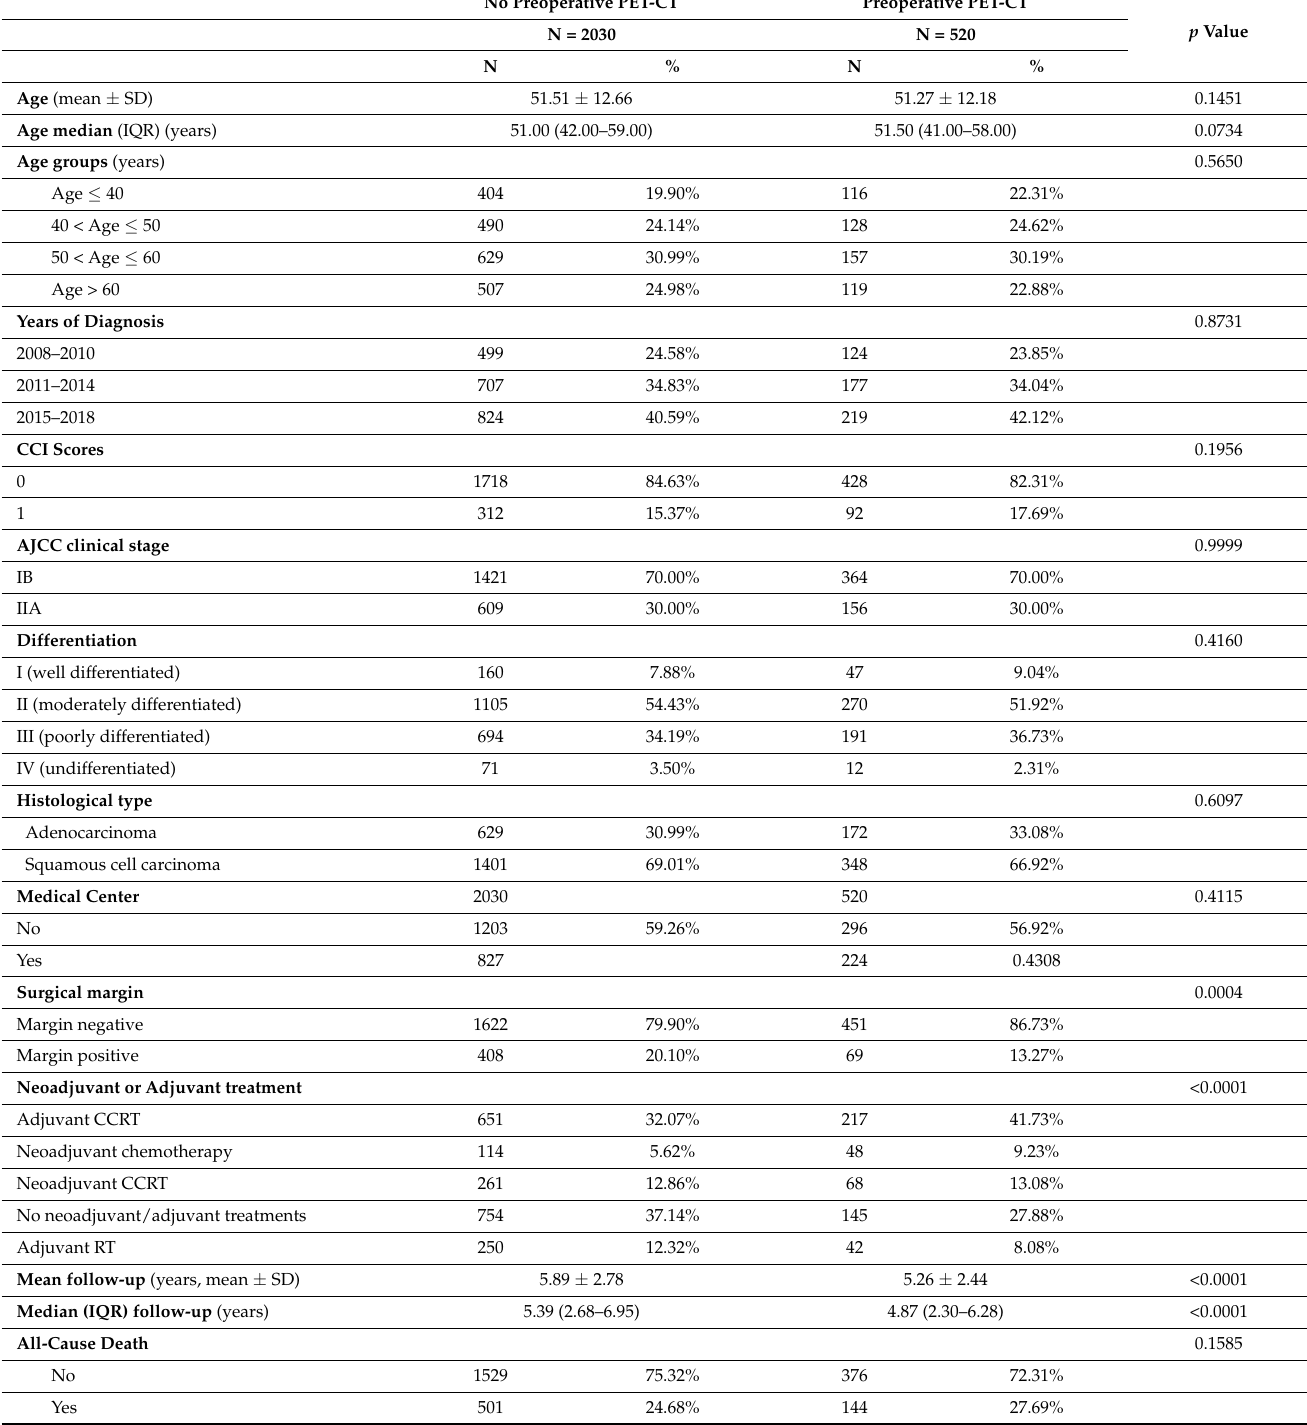
Table 1. Clinicodemographic characteristics of patients with cervical cancer with and without pretreatment PET–CT scan before curative surgery (after propensity-score